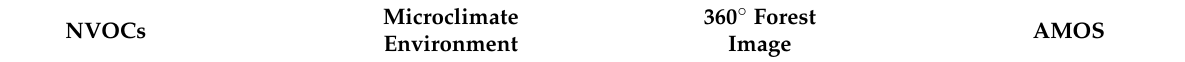
Table 1. Indicators for natural volatile organic compounds (NVOCs), microclimate environment, forest images, and Automatic Mountain Meteorology Observation System (AMOS) data that were measured for phytoncide-prediction equations.